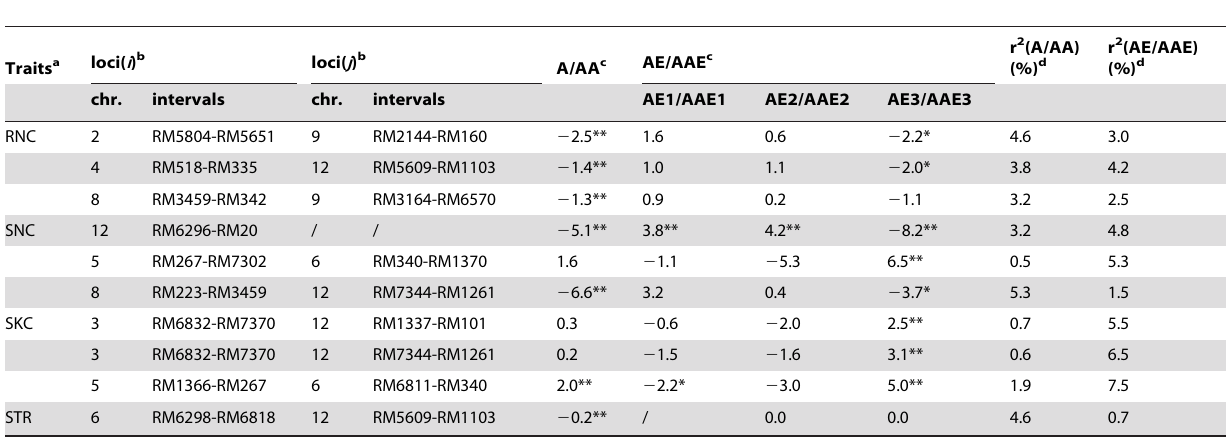
Table 4. Epistatic and QE interaction loci for relevant traits of RILs under different NaCl conditions by QTLNetwork.